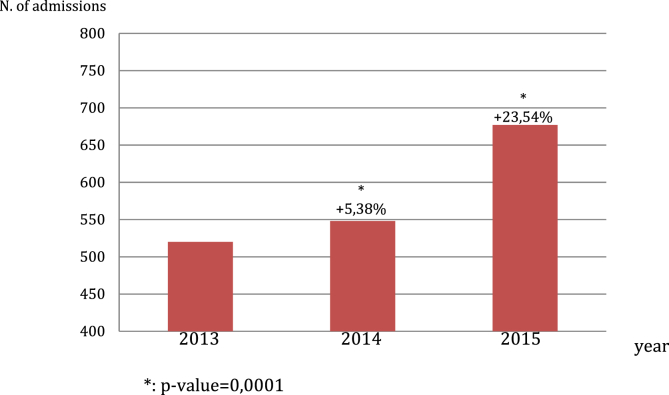
Trend of ER admissions for asthma within the considered timeframe.